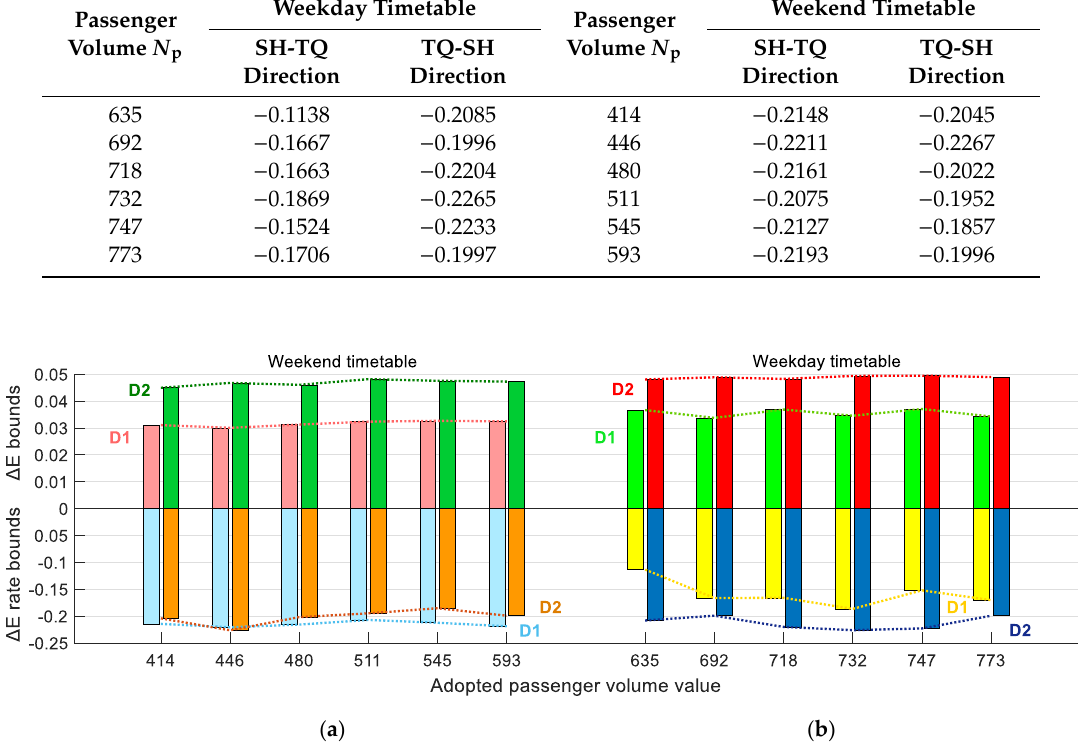
Table 6. Comparison of fitting slopes of ASS-RER-PLF upper boundaries.